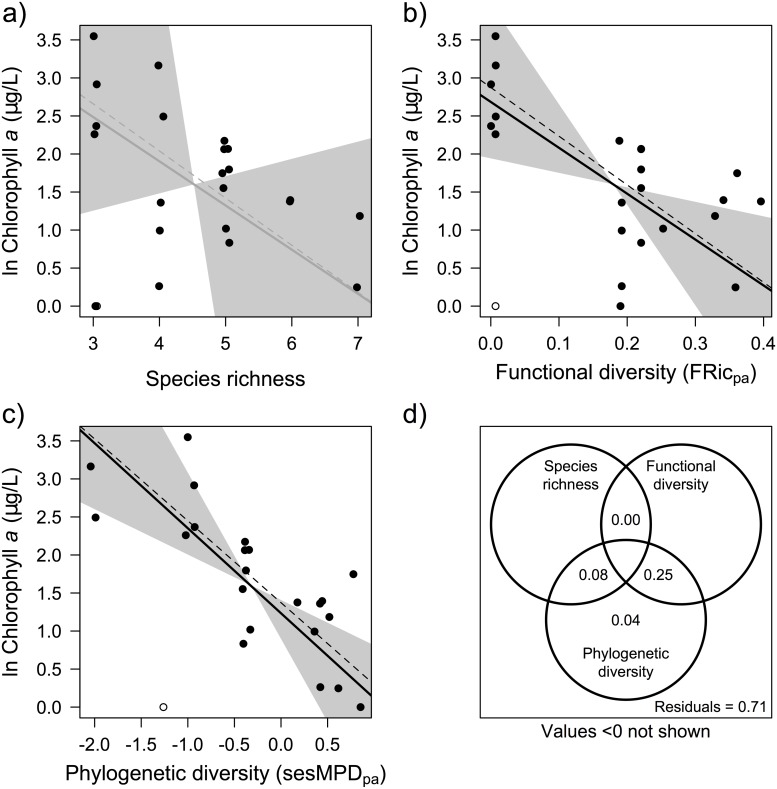
Chlorophyll a in the 23 ponds as predicted by the best diversity indices in each category: taxonomic diversity—species richness (a), functional diversity—functional richness (b), phylogenetic diversity—presence absence standard effect size mean pairwise distance (c), and the variation partitioning for these three models with their adjusted R2 (d).Significant model trends are shown as black lines. Insignificant model trends are shown as grey lines. The empty circles indicate the pond that is an outlier to the predicted trend. The dashed lines indicate the model trend when this outlier is removed. The grey bands indicate 95% confidence intervals for the slope of the regression lines.